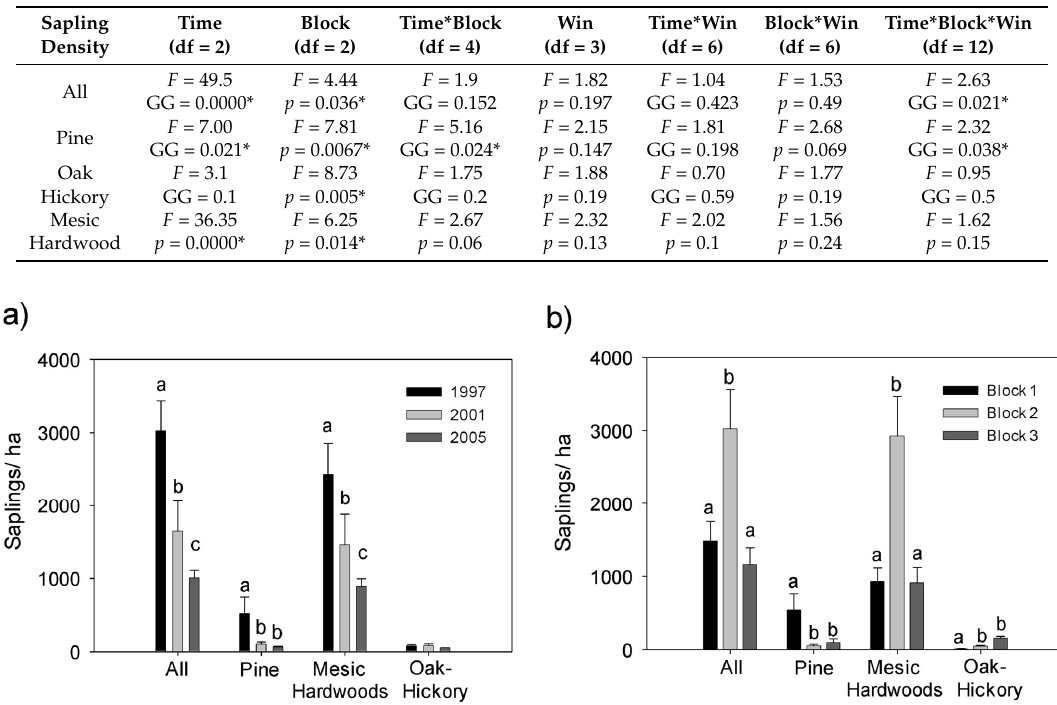
Table 2. Analysis of Variance for effects of repeated growing season burn effects on sapling density over time, block, and timing of burn window (Win) in mixed pine–hardwood forests of the Piedmont National Wildlife Refuge near Macon, Georgia, USA. p ‐ values ≤ 0.05 are noted with an *. Greenhouse–Geisser adjusted p ‐ values (GG) are given for those repeated measures data that did not meet circularity assumptions.